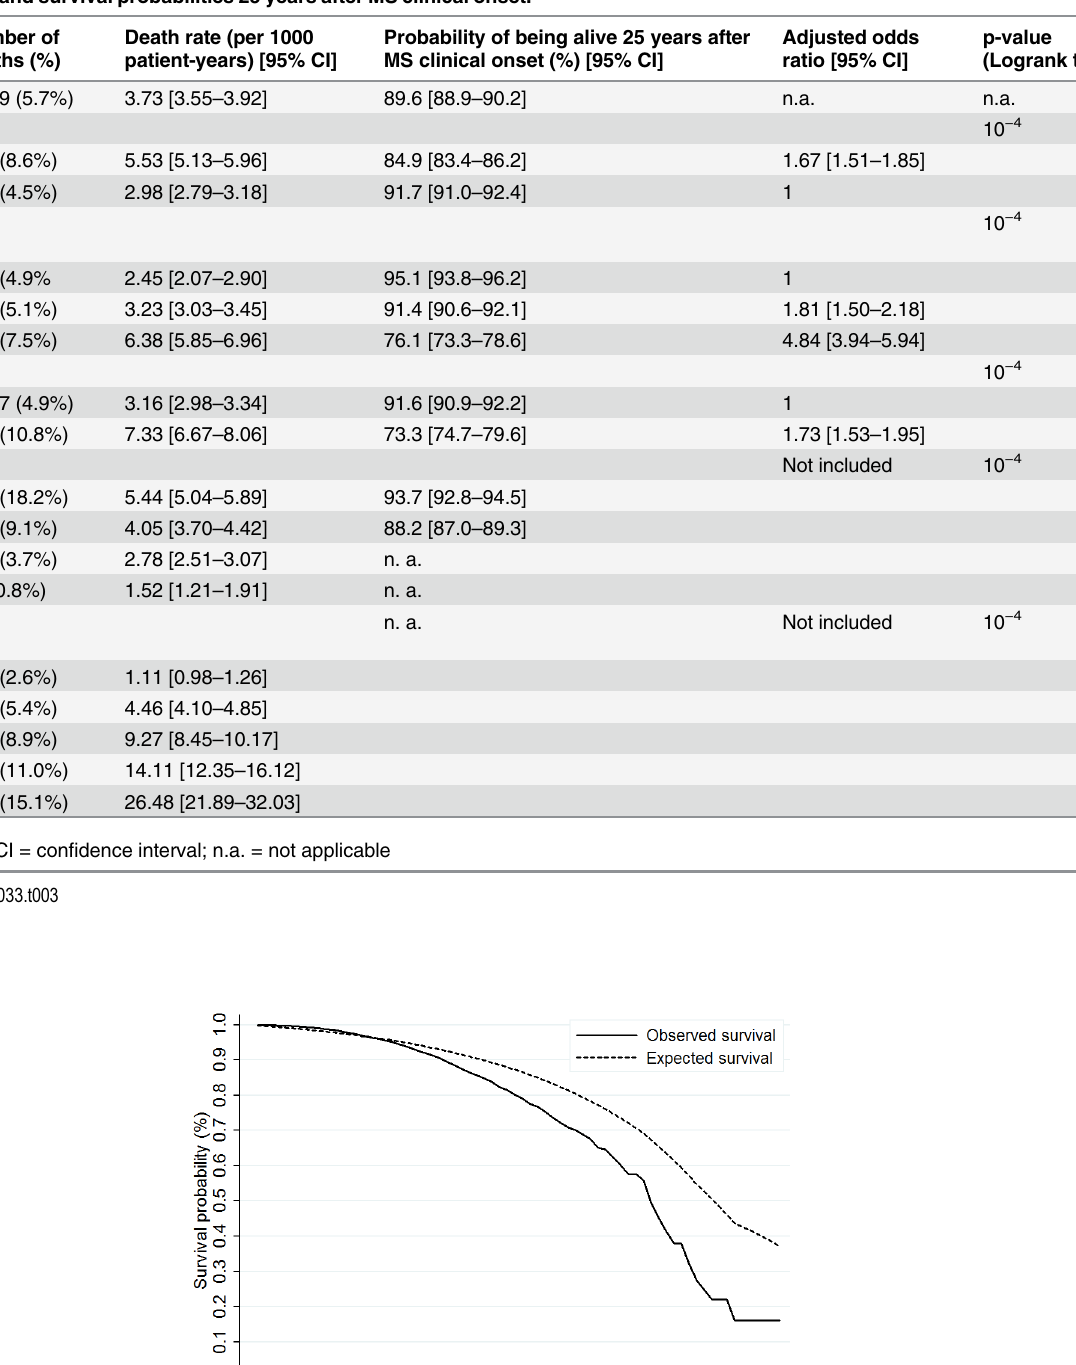
Table 3. Mortality rates and survival probabilities 25 years after MS clinical onset.